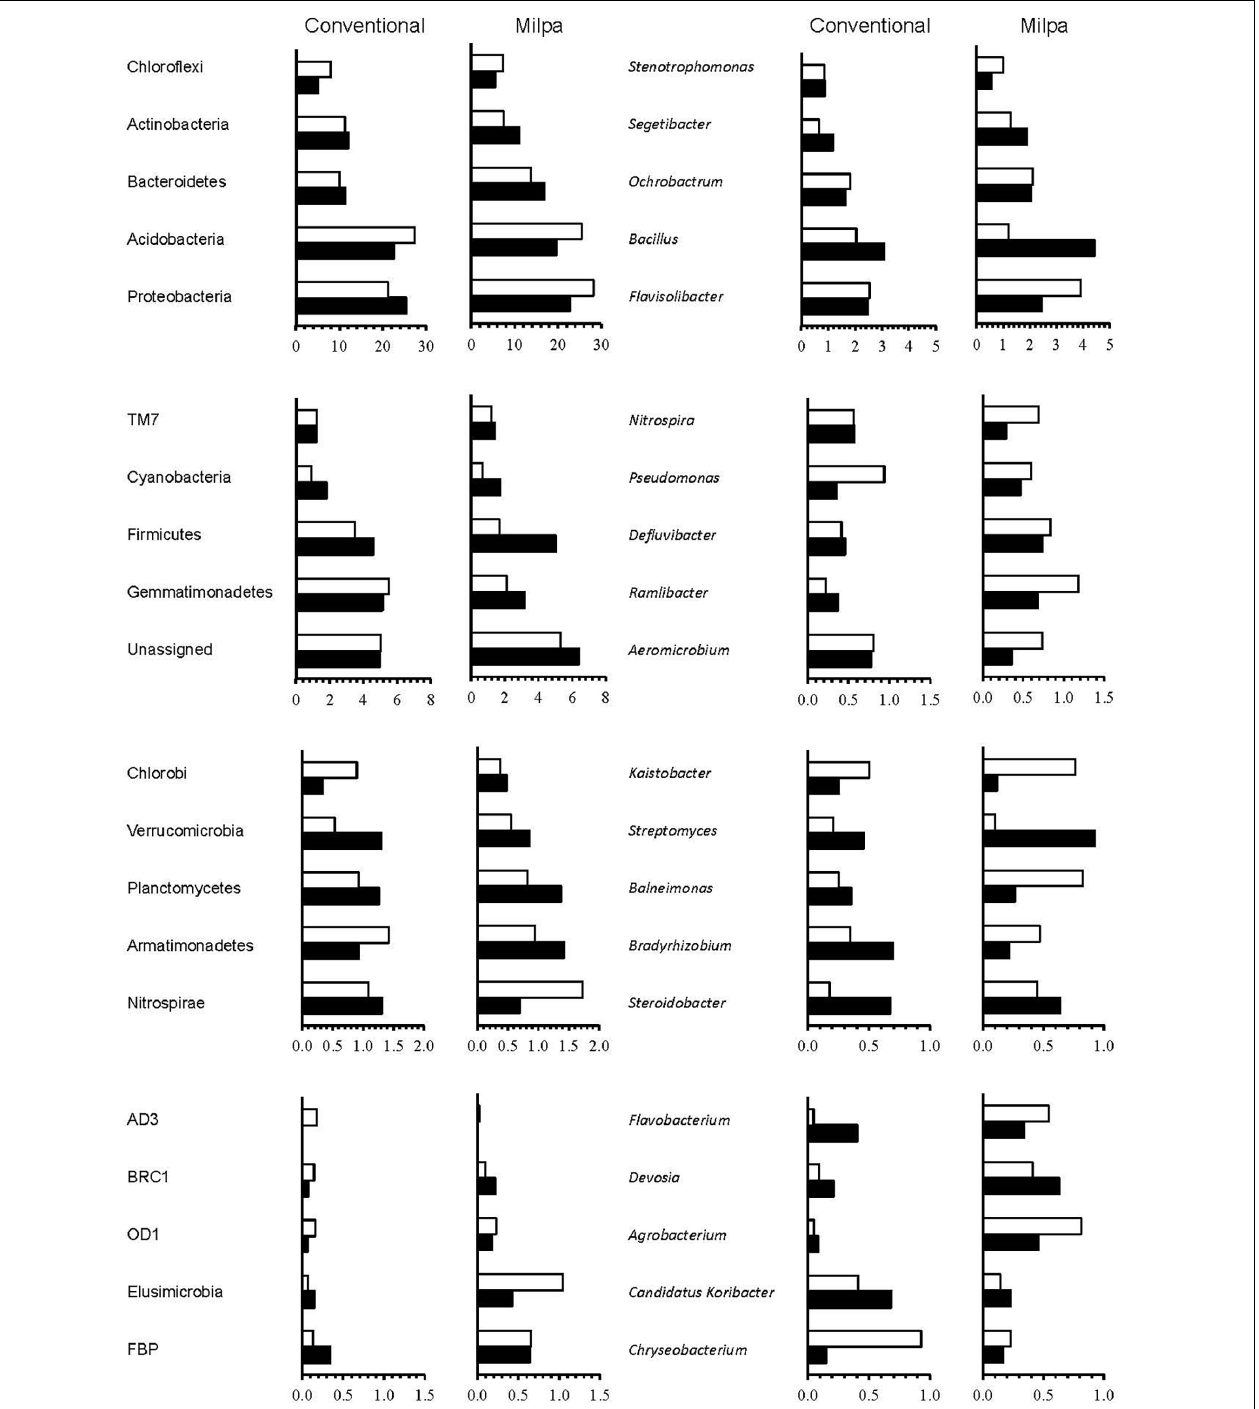
FIGURE 2 | Relative abundance of the most abundant bacterial phyla and genera in the milpa and the conventional cultivated soil incubated at field capacity (FC) ( (cid:3) ) and 5%FC ( (cid:4)